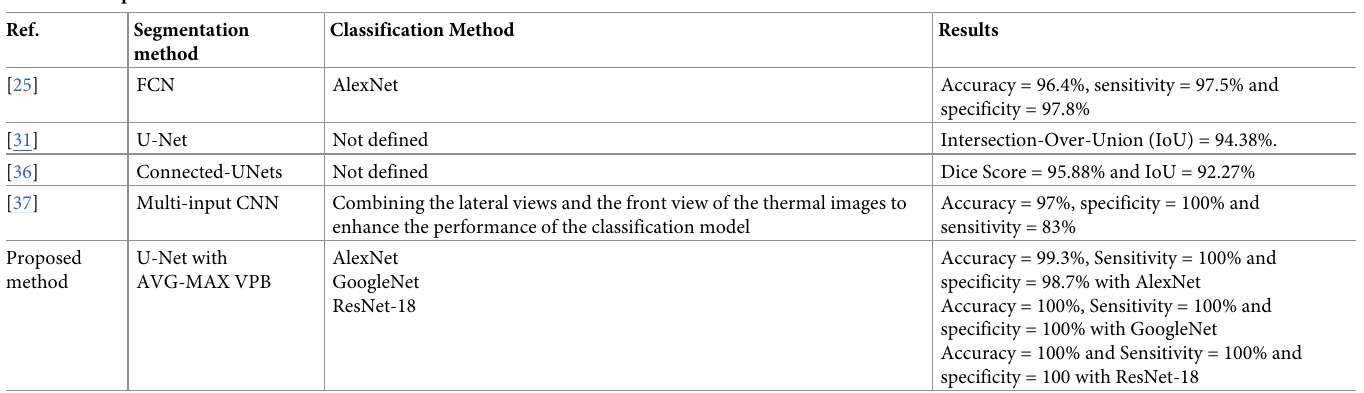
Table 4. Comparison with other studies on breast cancer detection with CNNs.